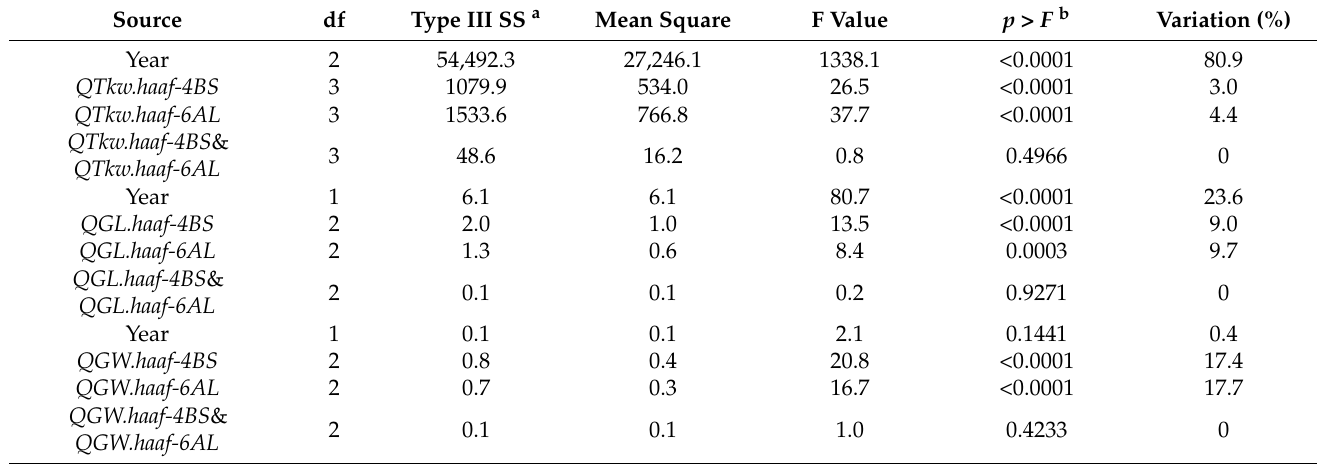
Table 5. Factor ANOVA analysis of two co-located loci for thousand kernel weight (TKW), grain length (GL) and grain width (GW) on the chromosomes 4BS and